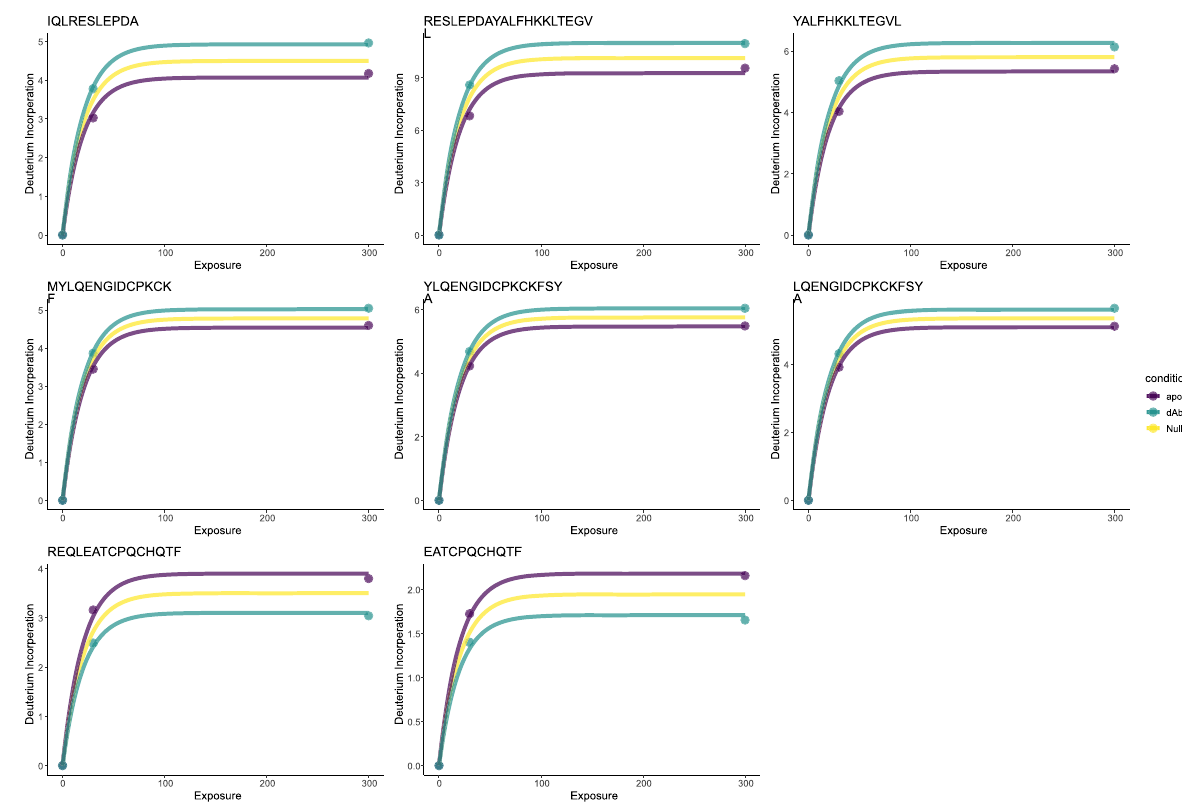
Fig. 5 Functional model identi fi es protected and unprotected region of HOIP-RBR in complexation with dAb 25. The top row contains kinetic plots for peptides in the helix-turn-helix region of HOIP; the middle row contains kinetic plots for peptides in the RING2 region of HOIP; the fi nal row contains proteins in the IBR region of HOIP. Deuterium incorporation is plotted in units of Daltons and Exposure to heavy water in seconds. Yellow lines indicate the null model, whilst green and purple indicate the alternative model.